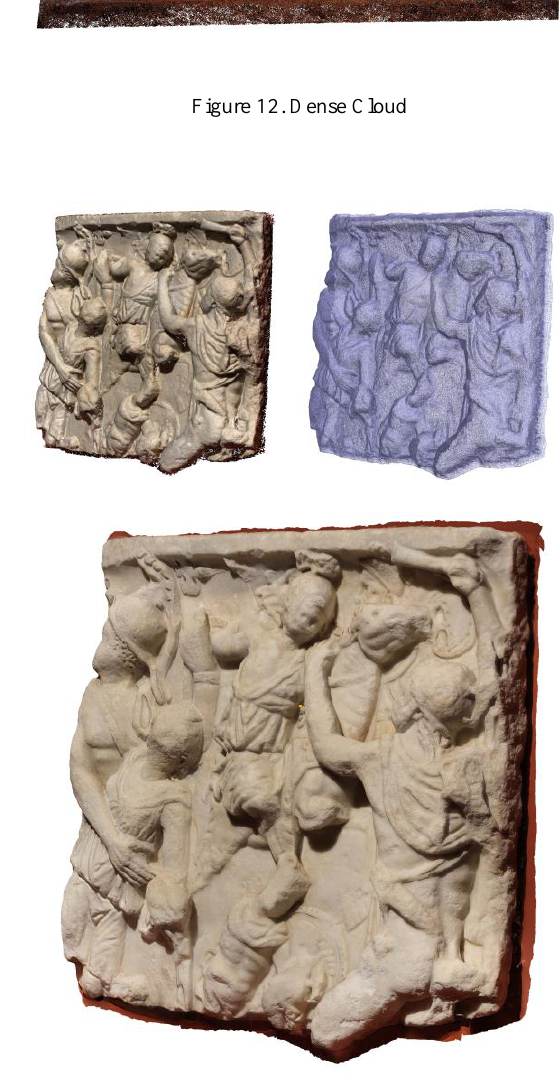
Figure 13. Metashape models (Dense Cloud, Mesh, Texture)